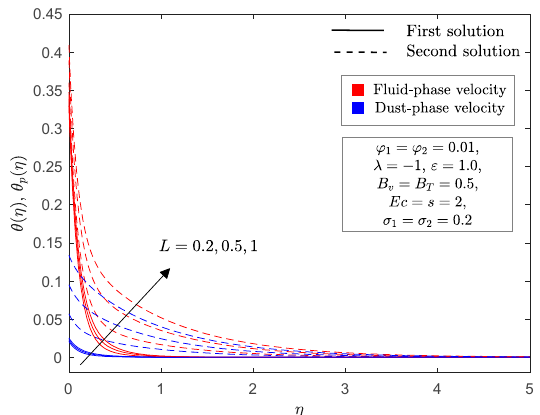
Figure 16. θ ( η ) , θ , p ( η ) for selected values of L , p